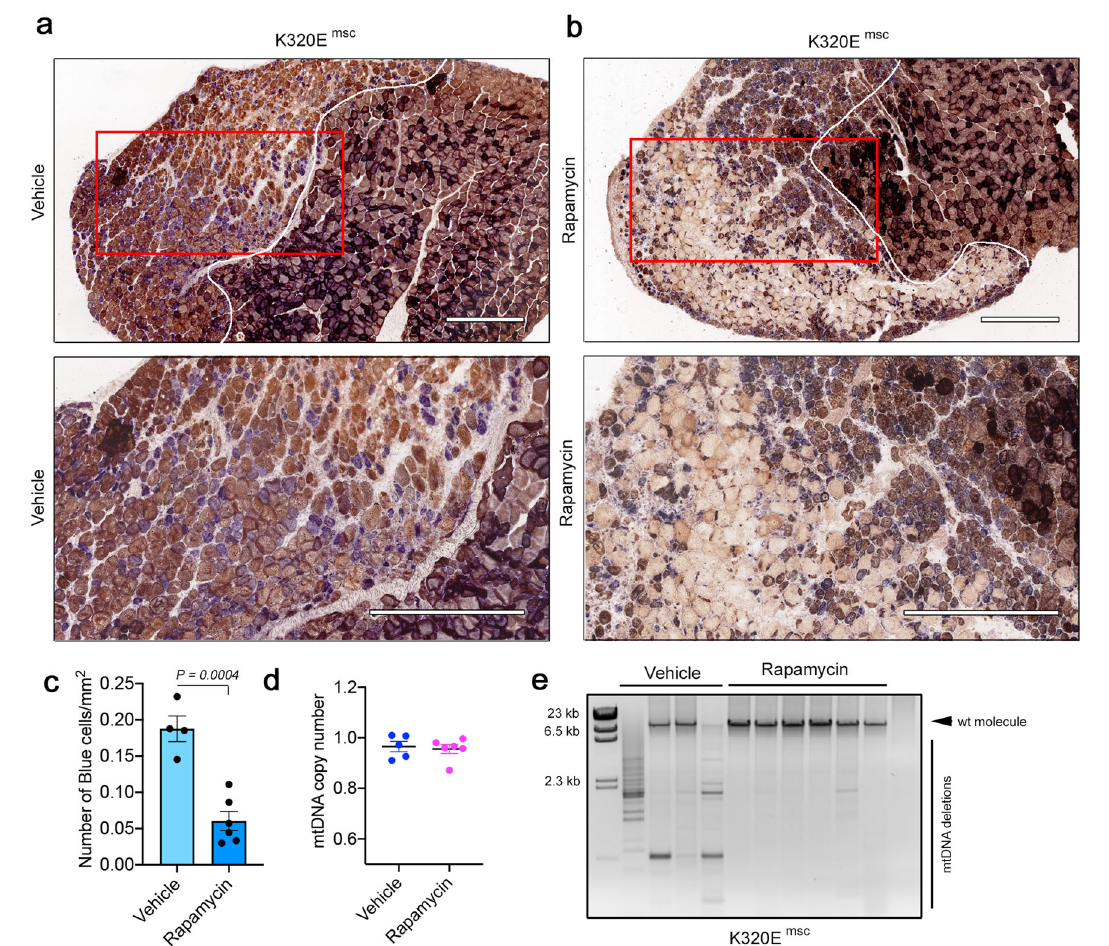
Fig.8|RapamycineliminatesmtDNAdeletionswithoutaffectingcopynumber in vivo. COX-SDH staining of regenerated TA muscle from Pax7-K320E mice (K320E msc ). After cardiotoxin-induced injury, mice were injected for 5 days either with a vehicle or b 2mg/kg Rapamycin. c Quanti fi cation of COX-negative cells